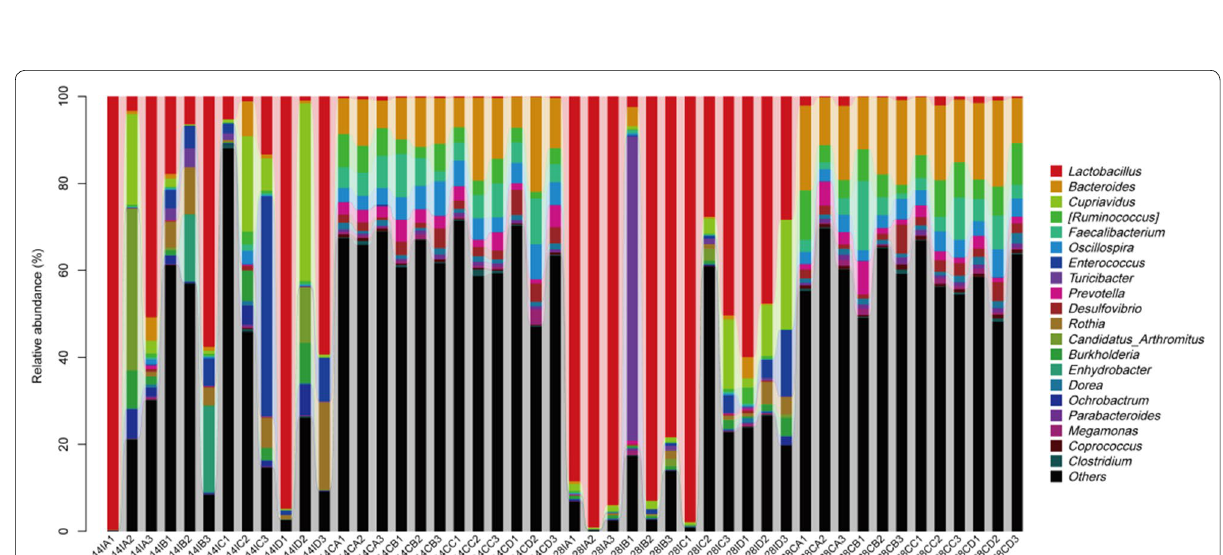
Fig. 6 The genus level distribution of ileal and cecal microbiota among groups. 14IA: 14‑d ileum control group; 14IB: 14‑d ileum Astragalus group; 14IC: 14‑d ileum L. plantarum group; 14ID: 14‑d ileum fermented Astragalus group; 14CA: 14‑d cecum control group; 14CB: 14‑d cecum Astragalus group; 14CC: 14‑d cecum L. plantarum group; 14CD: 14‑d cecum fermented Astragalus group; 28IA: 28‑d ileum control group; 28IB: 28‑d ileum Astragalus group; 28IC: 28‑d ileum L. plantarum group; 28ID: 28‑d ileum fermented Astragalus group; 28CA: 28‑d cecum control group; 28CB: 28‑d cecum Astragalus group; 28CC: 28‑d cecum L. plantarum group; 28CD: 28‑d cecum fermented Astragalus